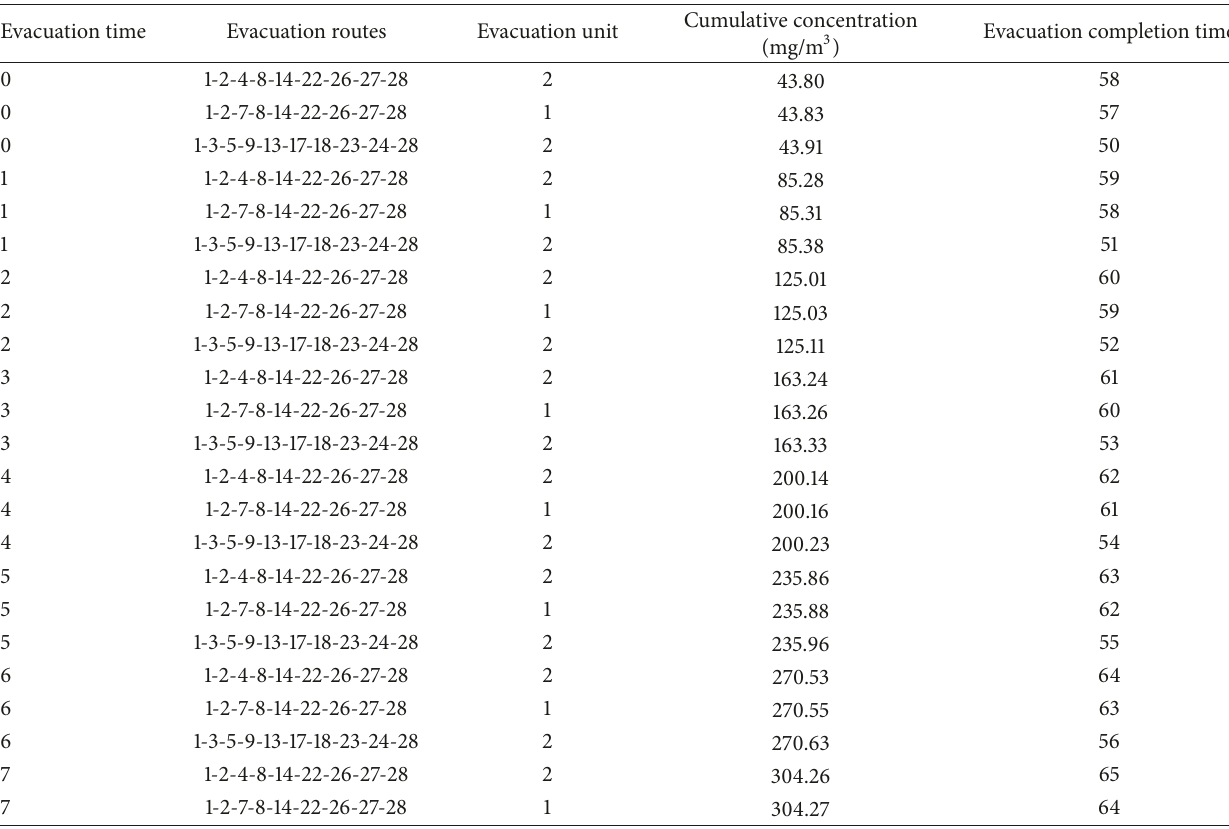
Figure 4: The evacuation network. Table 2: Evacuation route